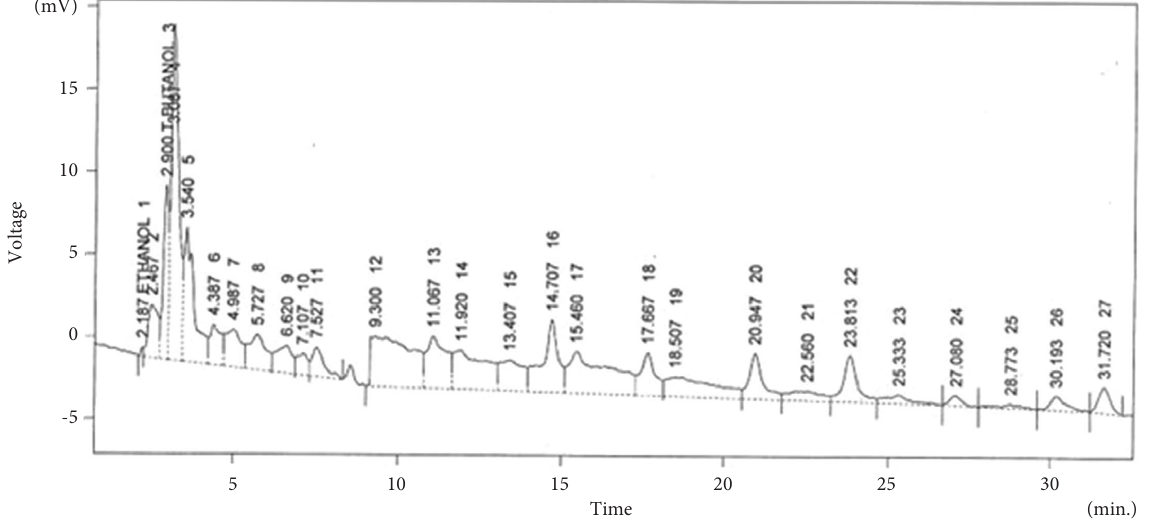
Figure 1: Representative HPLC chromatogram of Zingiber ofcinale